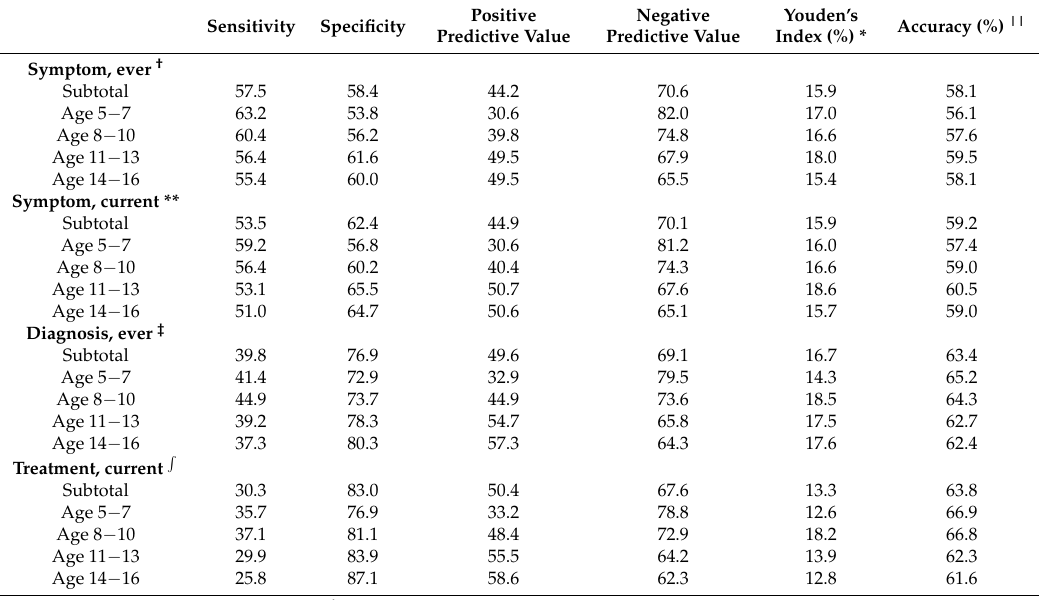
Positive Negative Youden’s Accuracy (%) || Predictive Value Predictive Value Index (%) *